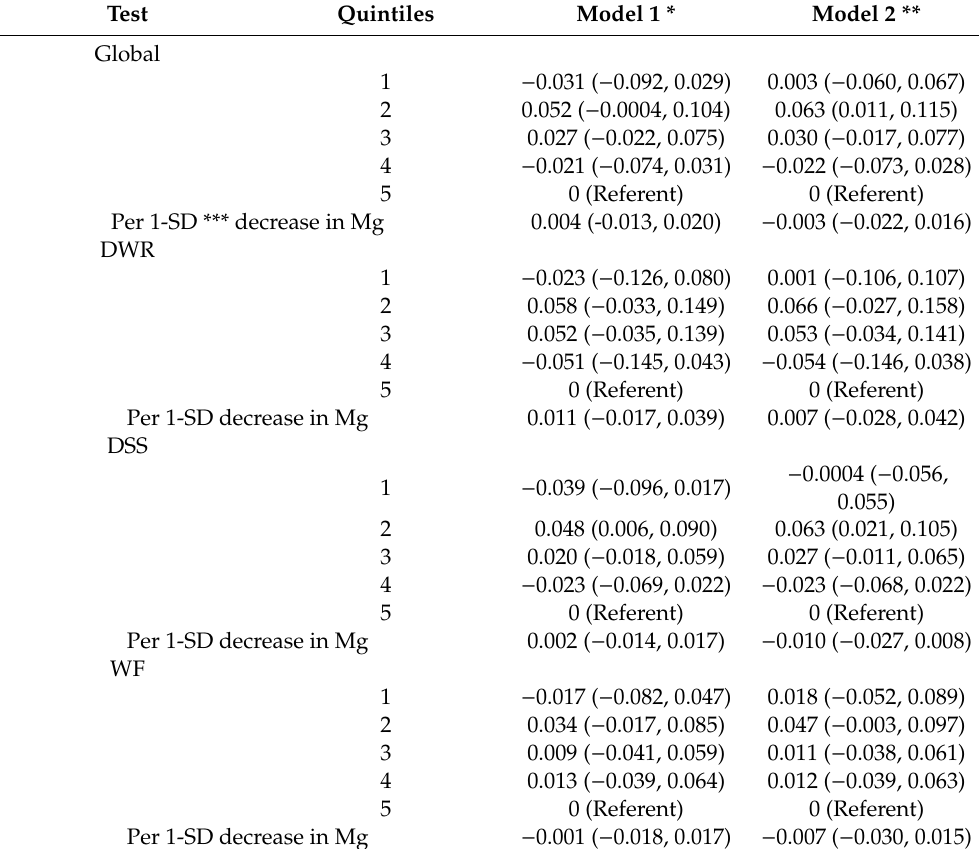
Table 3. Cognitive change over 27 years by baseline magnesium quintile, ARIC